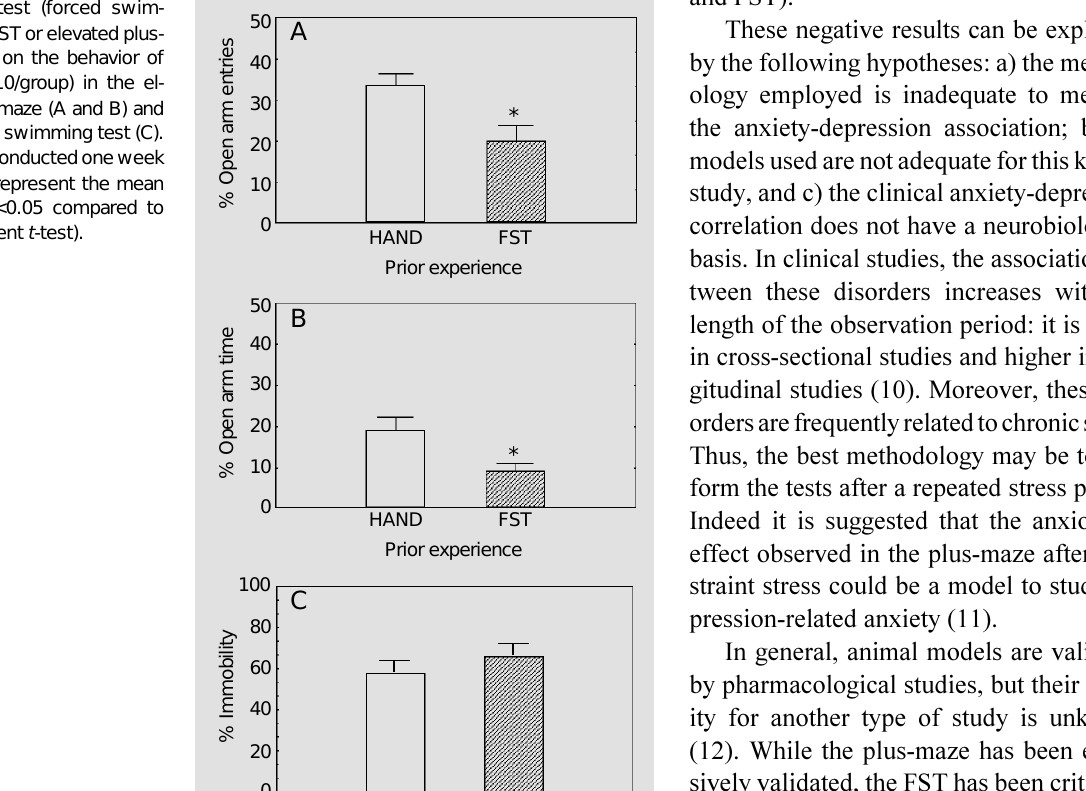
Figure 1 - Effect of prior handling (HAND) or test (forced swim- ming test - FST or elevated plus- maze - PM) on the behavior of mice (N = 10/group) in the el- evated plus-maze (A and B) and in the forced swimming test (C). Trials were conducted one week apart. Data represent the mean ± SEM. *P<0.05 compared to HAND (Student t